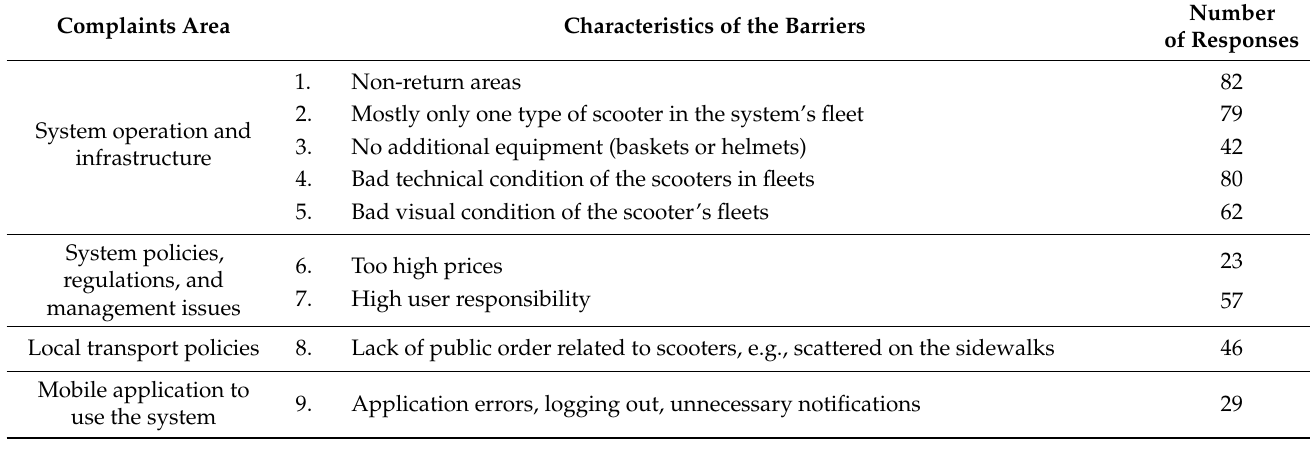
Table 6. Areas of complaints about scooter-sharing systems.